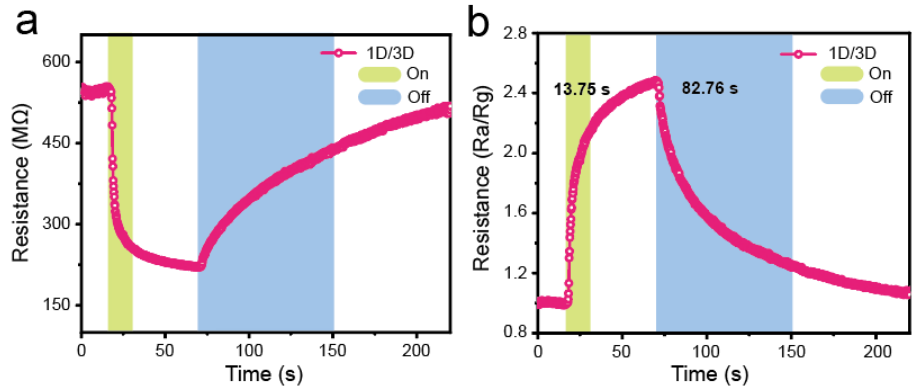
Figure 3. The transient ( a ) resistance and ( b ) response of the 1D/3D PyPbI 3 /FACs perovskite-based sensor toward 10 ppm NO 2 . sensor toward 10 ppm NO 2